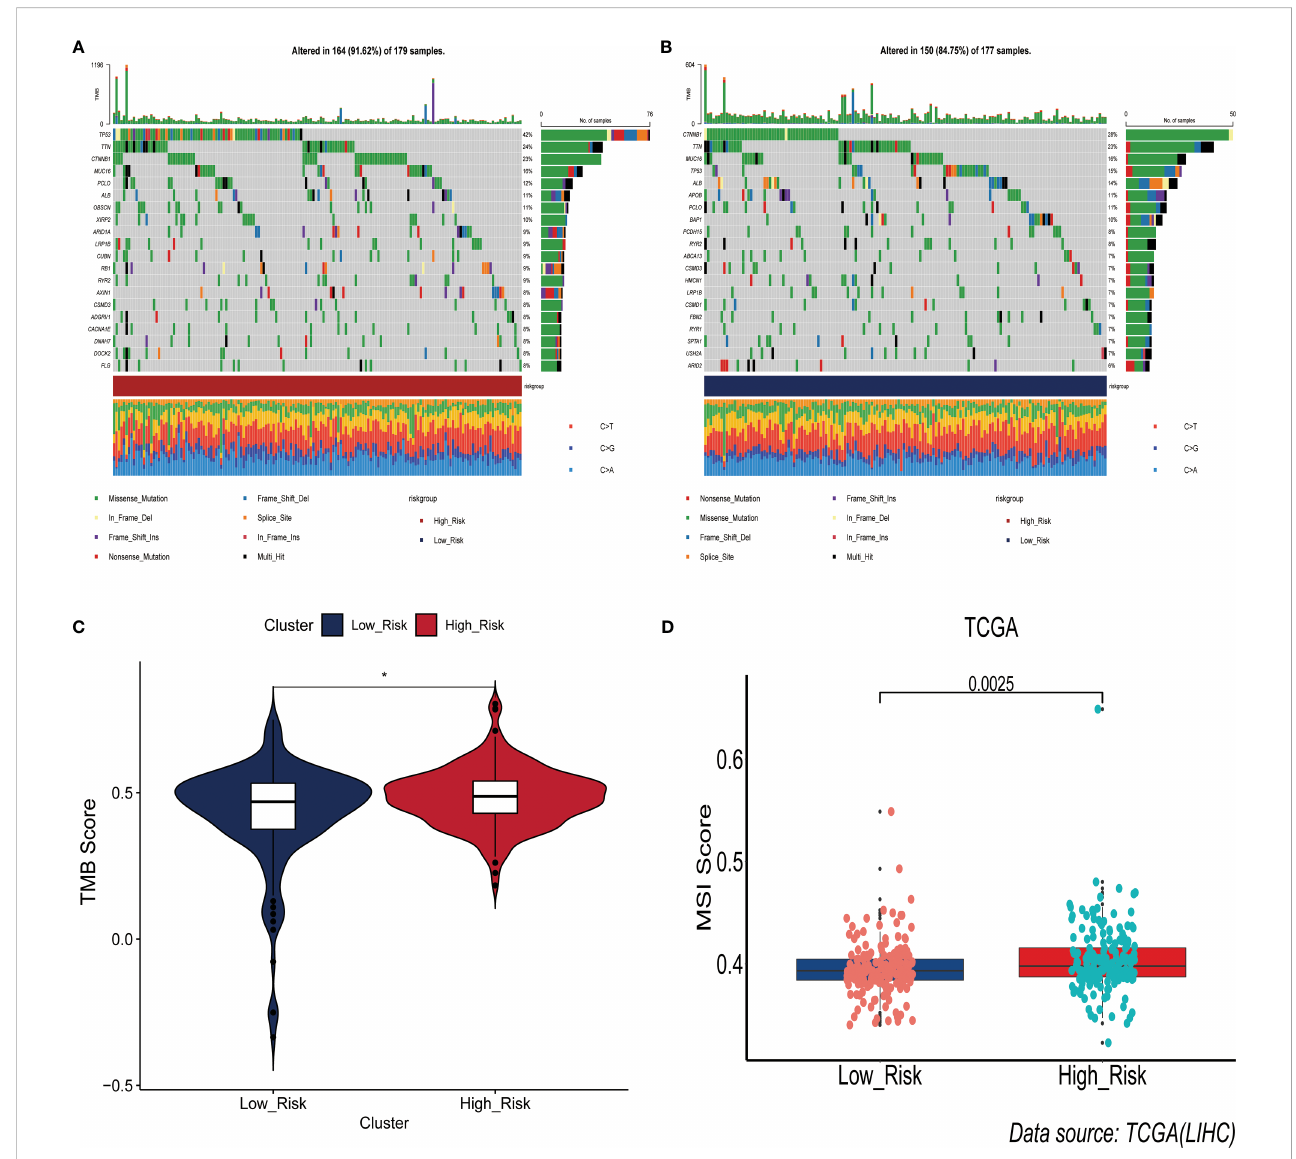
FIGURE 6 Association between prognostic signature and somatic mutations. (A) Landscape of somatic gene mutations in high-risk group of HCC patients. (B) Landscape of somatic gene mutations in low-risk group of HCC patients. (C) Differences between high- and low-risk groups in tumor mutation burden. (D) Differences in the distribution of microsatellite instability between the high- and low-risk